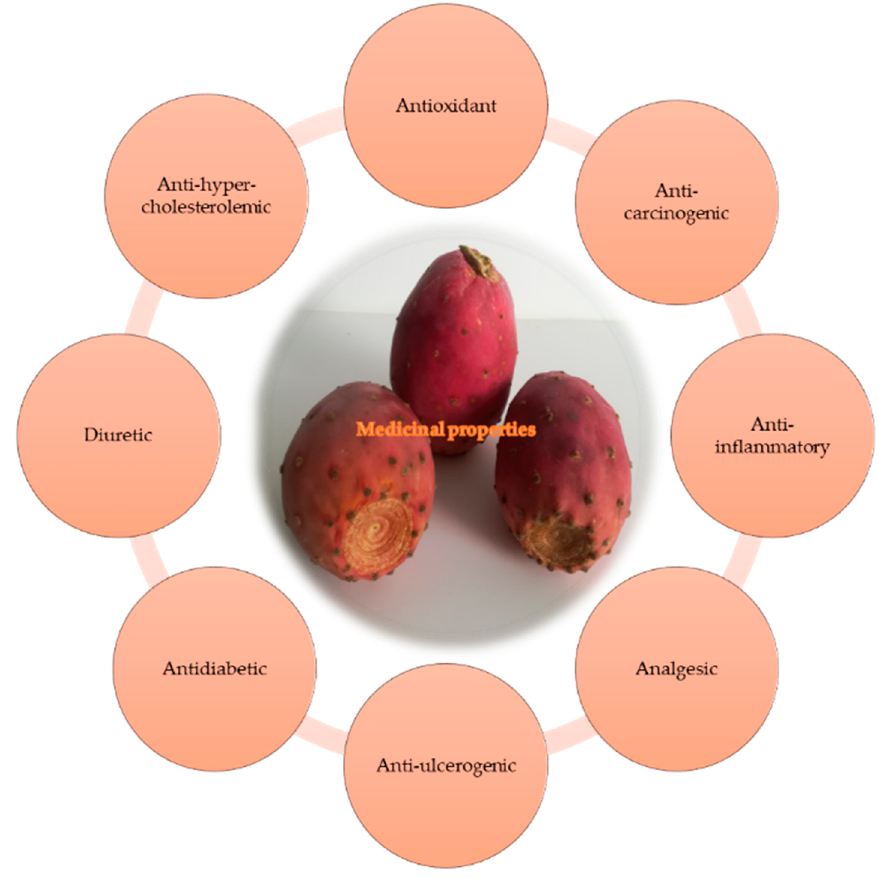
Figure 3. OFI’s medicinal properties